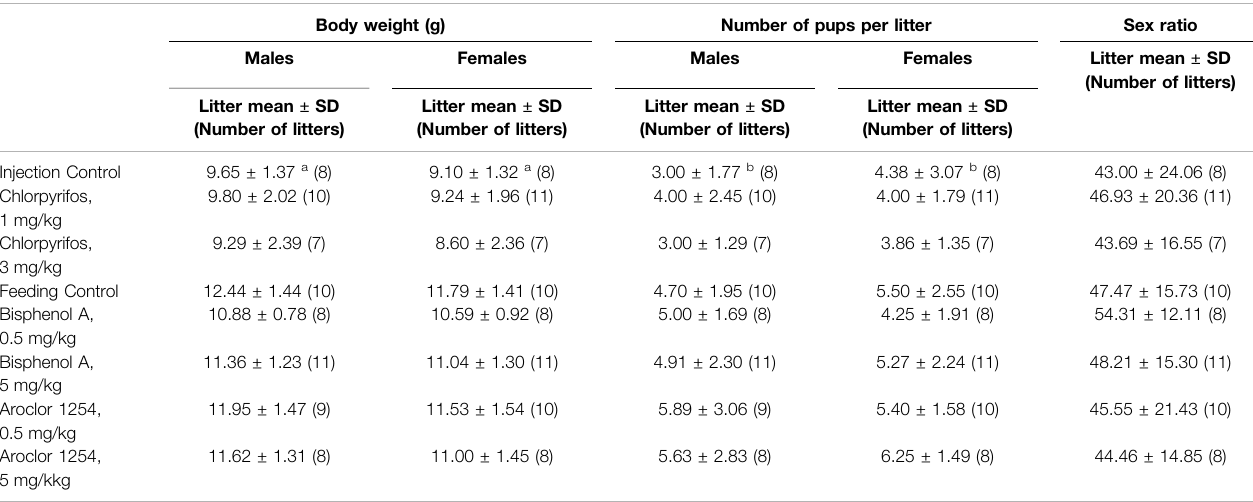
TABLE 1 | Body weight and number of rat offspring at postnatal day 6 (litter